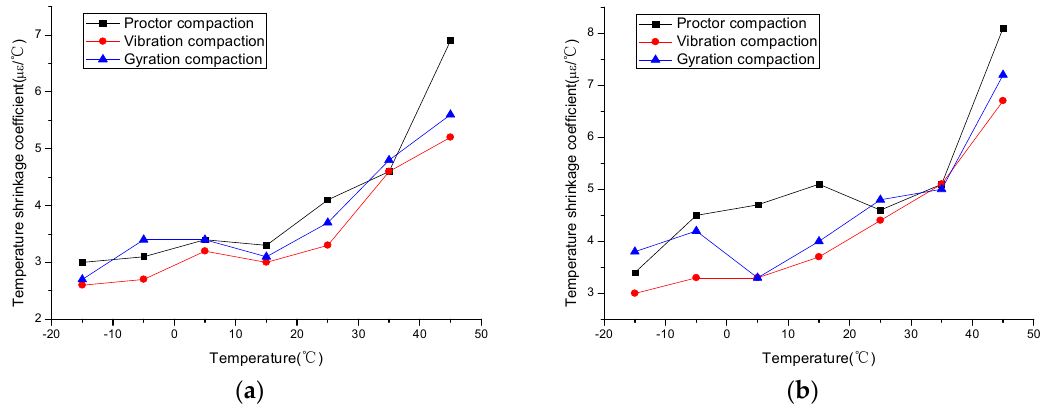
Figure 14. Temperature shrinkage coefficients of ( a ) Aggregate A and ( b ) Aggregate B.